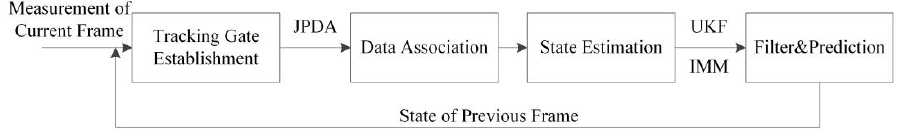
Figure 1. The workflow of this